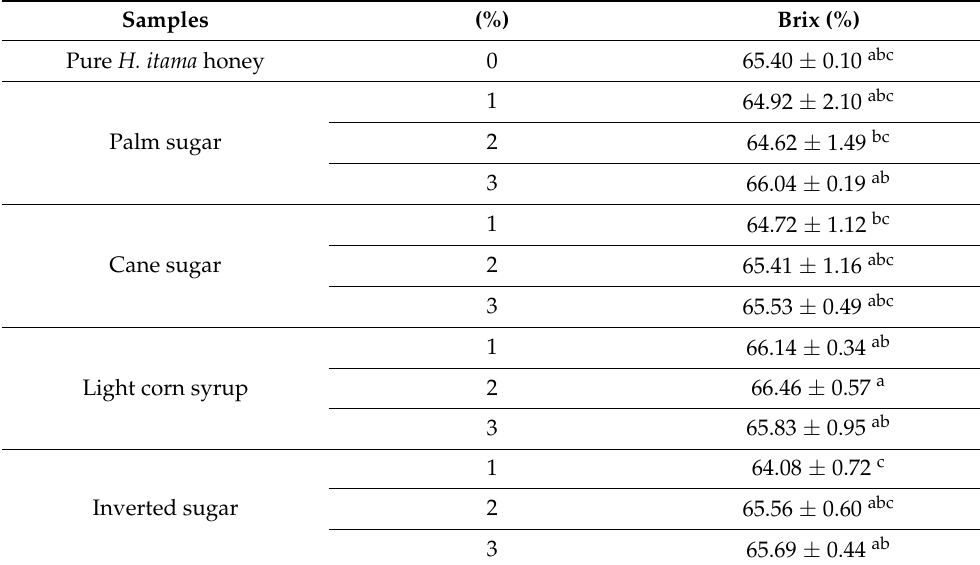
Table 1. The Brix value (%) of H. itama honey adulterated with different sugars at different concentrations.